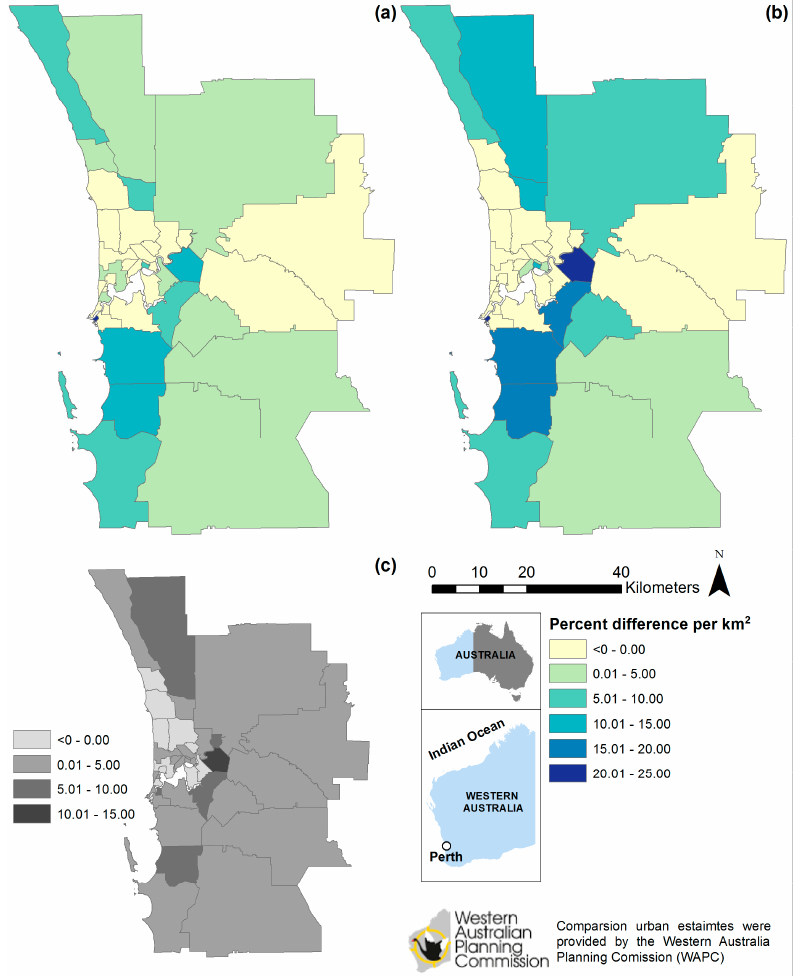
Figure 4. Percentage differences relative to local government area size, permitting a change metric standardised by Local Government Area (LGA) area between Earth Observation (EO) and the Western Australian Planning Commission’s (WAPC) urban estimates for: ( a ) 2000 (EO) and 2001 (WAPC) and ( b ) 2012 (WAPC) and 2013 (EO), whilst ( c ) depicts the percentage difference in the relative urban rate of change (km 2 per LGA area) between 2000 and 2013 (EO) and 2001 and 2012 (WAPC). Positive values indicate underestimation by WAPC whilst negative values represent overestimation by WAPC.